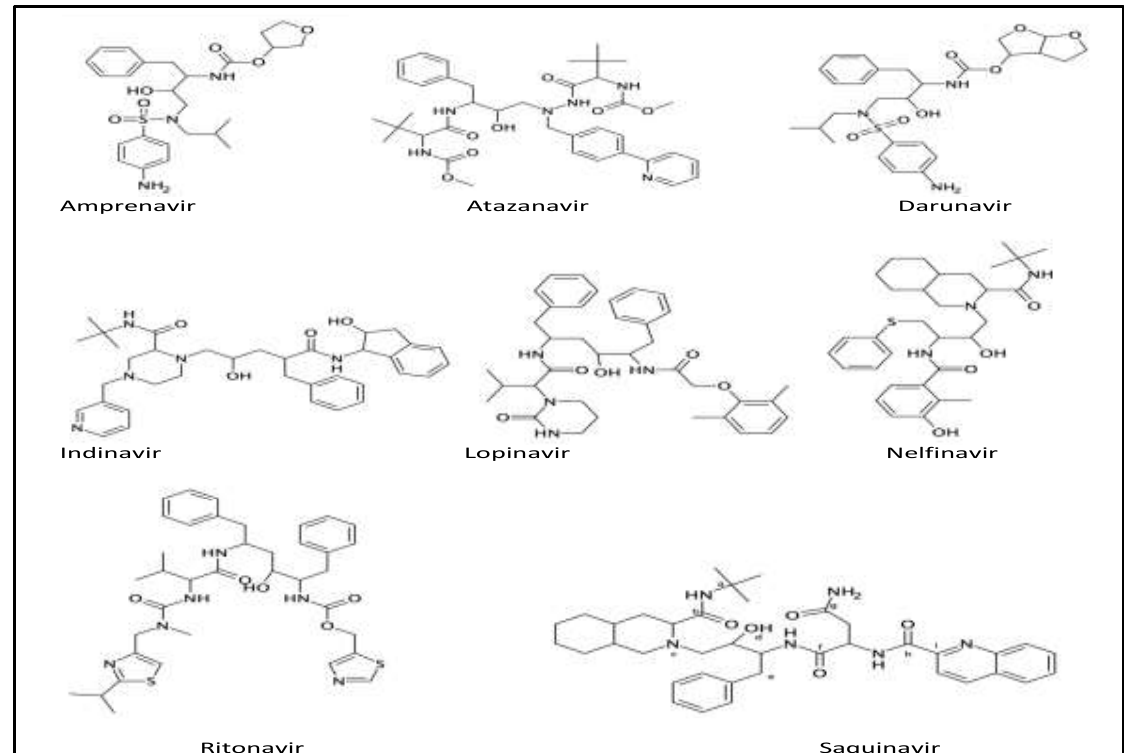
Figure 1. Structures of some of the HIV-1 protease inhibitors.